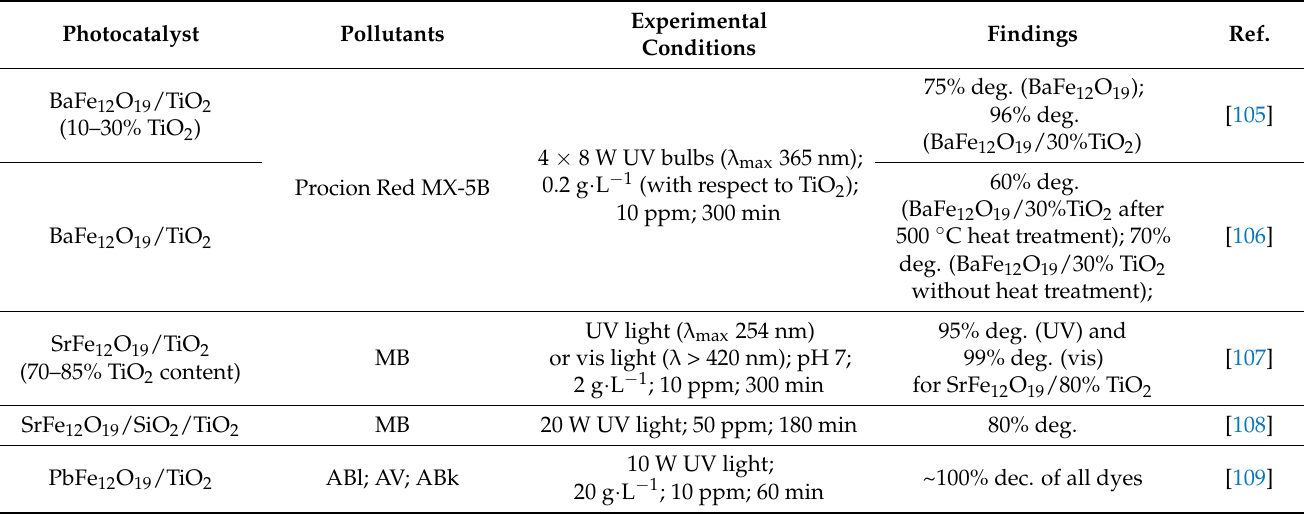
Photocatalyst Pollutants